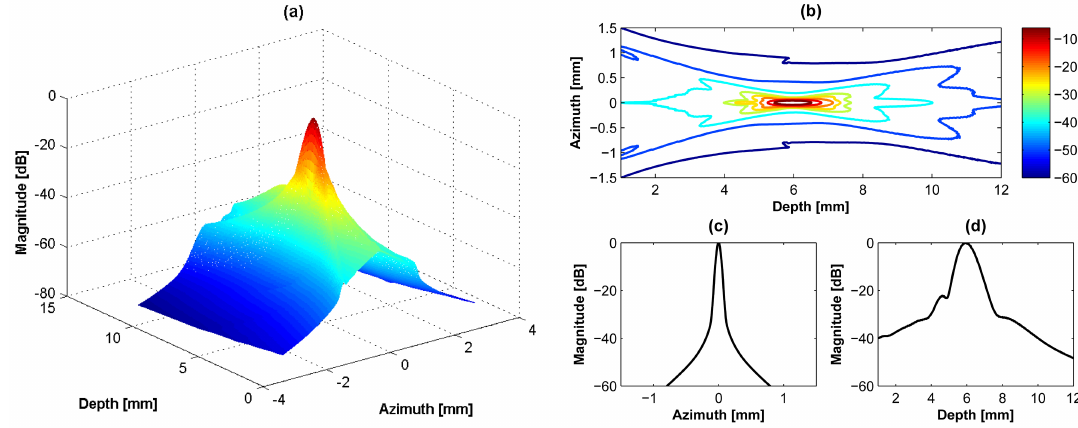
Figure 2. Simulation about single element transducer: ( a ) 3D transmit beam profile, ( b ) 2D transmit beam distribution, ( c ) lateral beam plot, and ( d ) axial beam plot. Note that the color bar in (b) indicates the intensity value in decibel scale and applied to (a). (c) and (d) are obtained from the maximal intensity at 6 mm focal point. The position of the transducer is on the azimuth direction in (a).